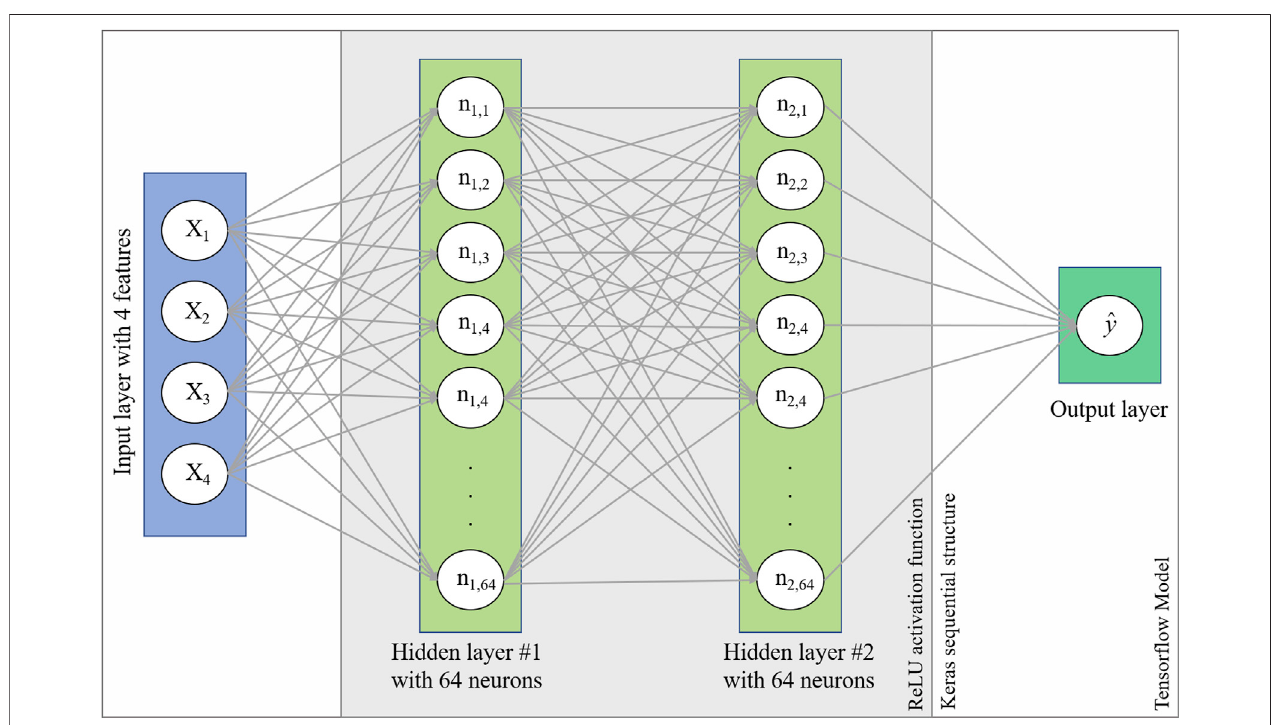
FIGURE3| ThemultilayerDNNmodelstructurewithfourfeaturesintheinputlayer,twohiddenlayerseachwith64neurons,andtheoutputlayerconstructedusing Keras library and implemented in TensorFlow model.